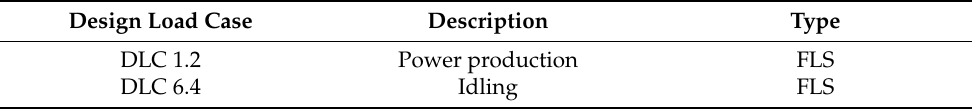
Table 7. Design load